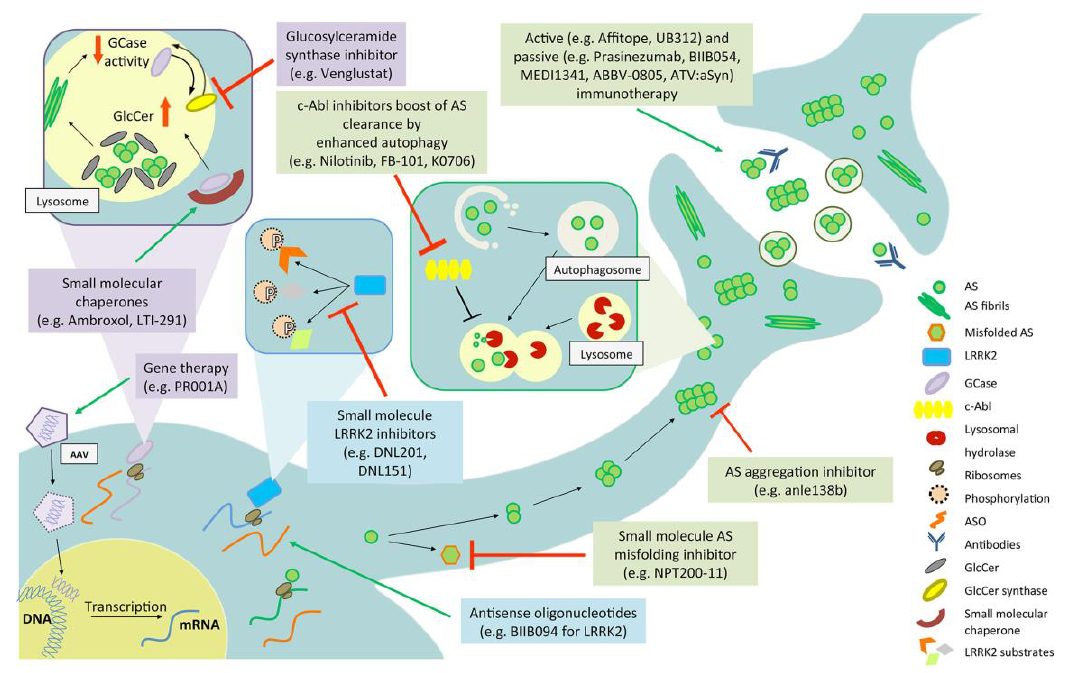
Figure 2. Mechanisms of action of the potential therapeutic compounds currently in clinical trials. As, Alpha-synuclein; ASO, Anti-sense oligonucleotides; GlcCer, Glucosylceramide; LRRK2, Leucine-rich repeat kinase 2.